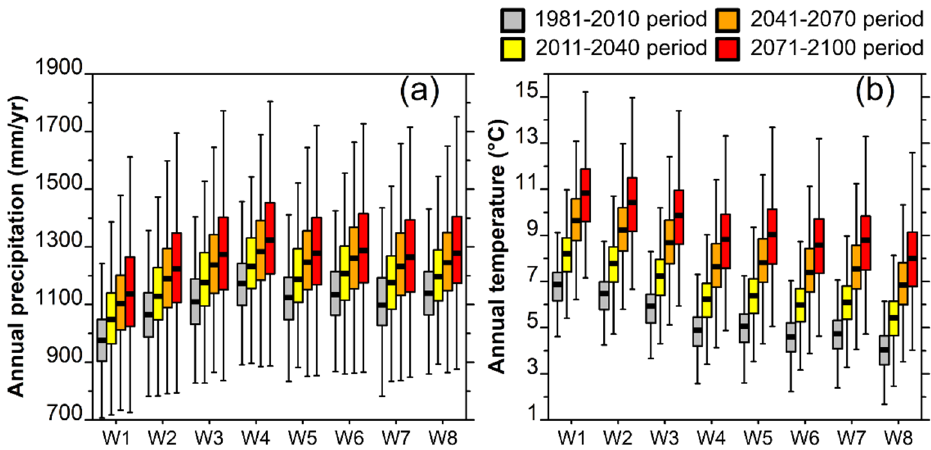
Figure 3. Thirty-year period change of mean annual precipitation ( a ) and annual temperature ( b ) of